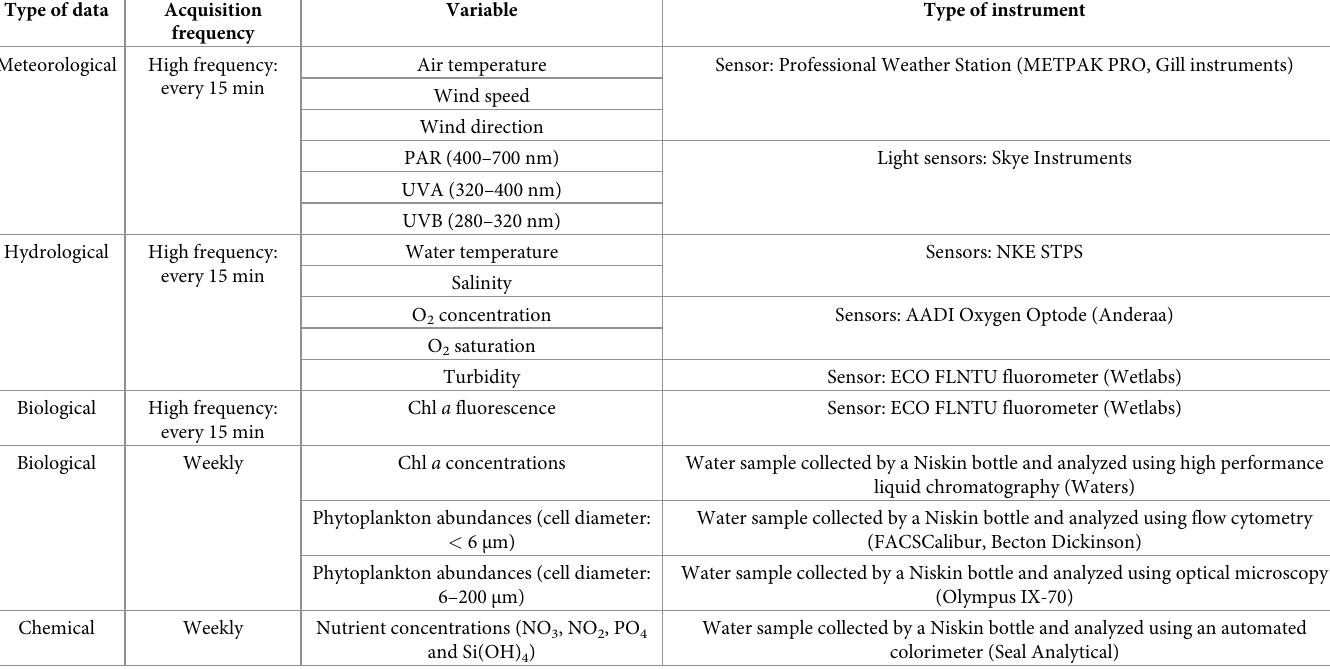
Table 1. Type and acquisition characteristics of the studied